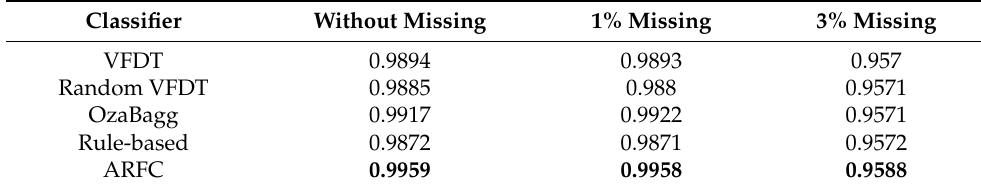
Figure 7. Comparison of ARFC performance with using EFDT as Model-based imputation technique against the other three techniques. Table 5. Comparison of ARFC accuracy with four stream classifiers in presence of missing class values without Model-besed